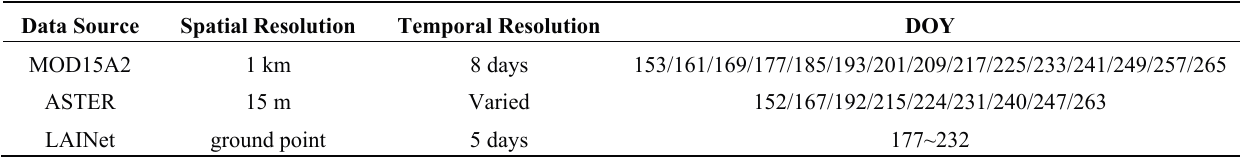
Table 1. The spatial and temporal information of satellite data and the ground